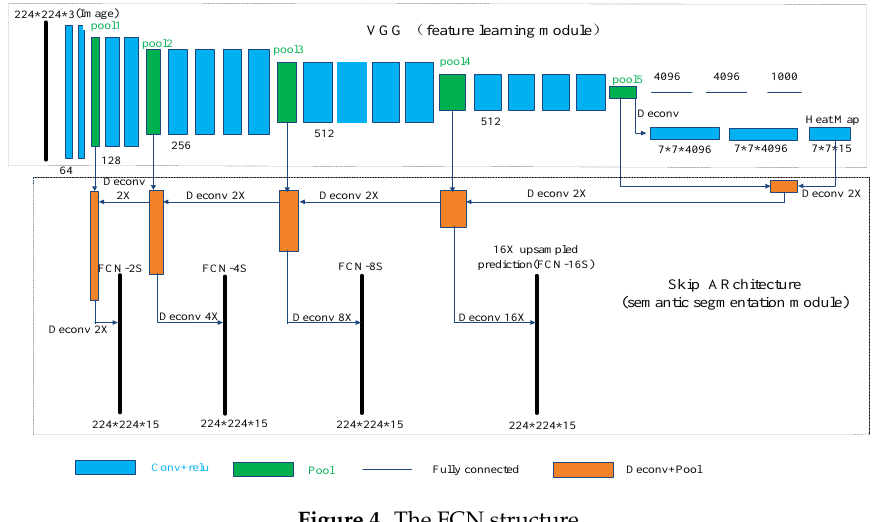
Figure 4. The FCN Figure 4. The FCN structure.